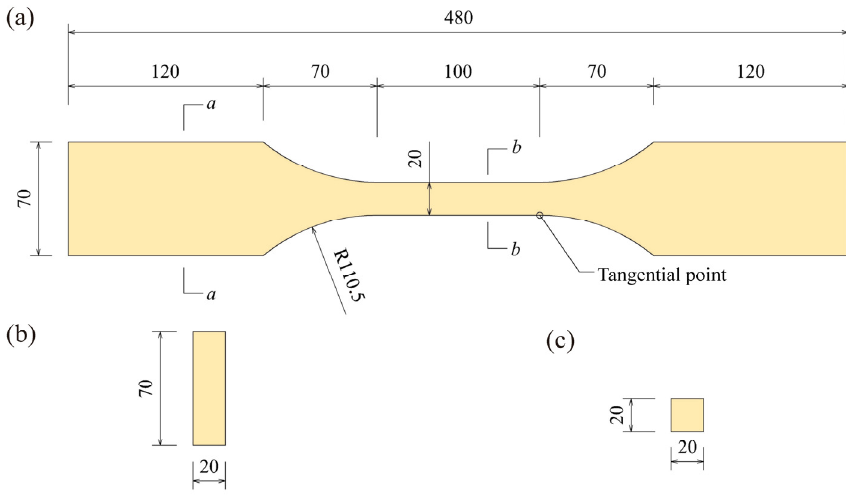
Figure 2. Dimensions of specimens perpendicular to grain in short-term and long-term tests: ( a ) whole specimen, ( b ) section a–a, ( c ) section b–b.